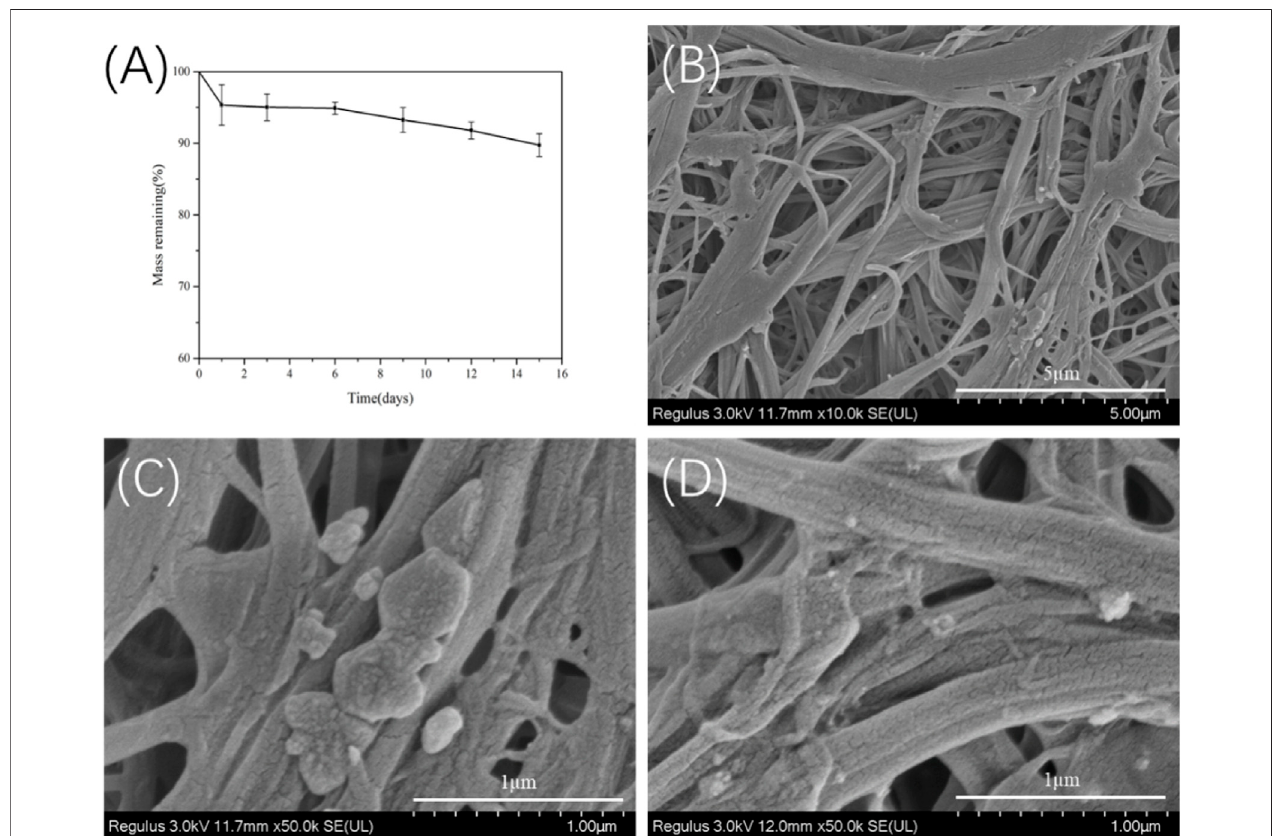
FIGURE9| Invitro enzymaticdegradationofthe30TSFnano fi bermat (A) Massremainingversusdegradationtime(n (cid:1) 3pertimepoint) (B – D) SEMobservationof the 30TSF nano fi ber mat after degradation for 15 days.